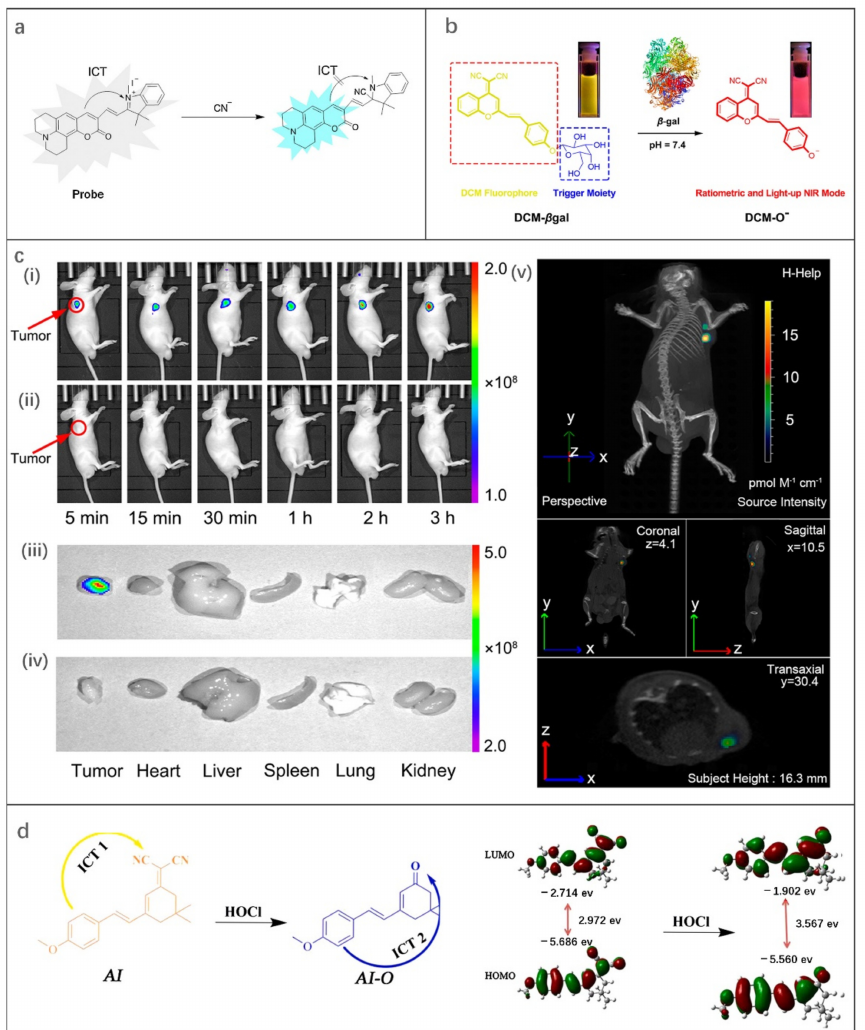
Figure 4. ( a ) The ICT mechanism of the probe. Reproduced with permission from Ref. [63], copyright 2015, Elsevier B.V. ( b ) The ICT mechanism of DCM- β gal. ( c ) ( i , ii ) In vivo imaging of β -gal activity in tumor-bearing nude mice after tumor injection, ( iii , iv ) fluorescence images of the main internal organs after anatomy, ( v ) three-dimensional in vivo imaging of β -gal activity in tumor-bearing nude mice after tumor injection of DCM- β gal for 3 h. ( i , iii , v ) Avidin- β -gal (100 µ g) in PBS was intravenously injected into LoVo-implanted mice, and after 18 h DCM- β gal was then injected into the mice. ( ii , iv ) Tumor-bearing mice were not pretreated with avidin- β -gal before injection of DCM- β gal acting as the control. Reproduced with permission from Ref. [64], copyright 2022, American Chemical Society. ( d ) Theoretical calculation of HOMO/LUMO energy gaps of AI and AIO. Reproduced with permission from Ref. [67], copyright 2020, Elsevier